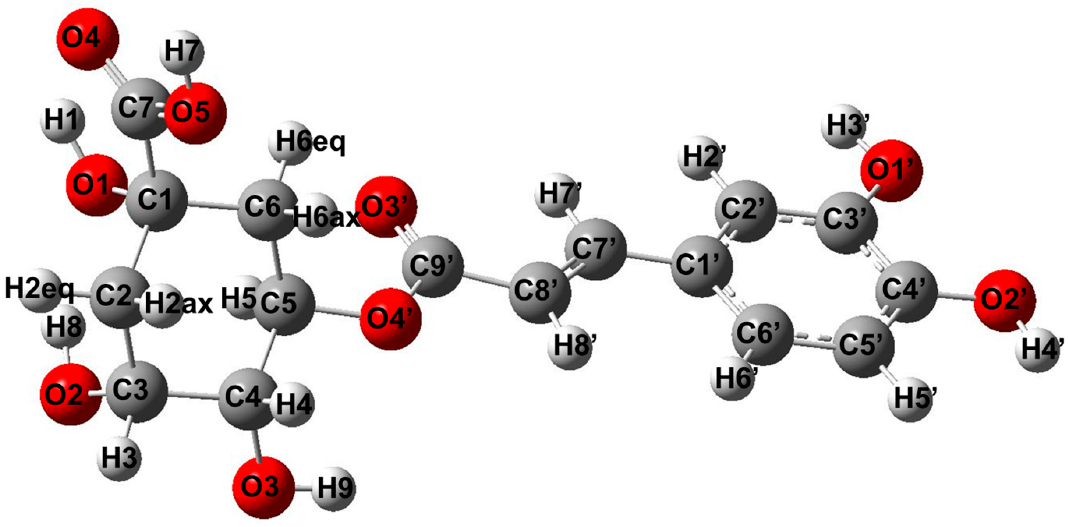
Figure 1. The calculated in B3LYP/6-311++G** level structure of chlorogenic acid with atom numbering.